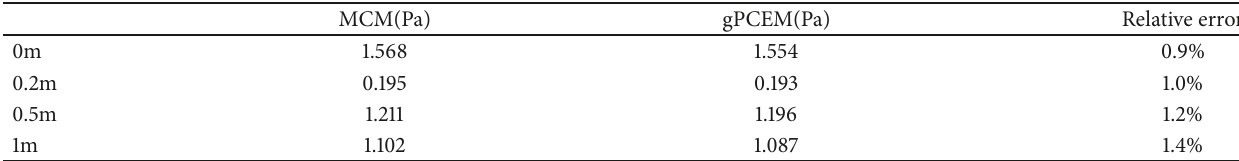
Table 3: Relative error of variance of the sound pressure’s imaginary parts yield by